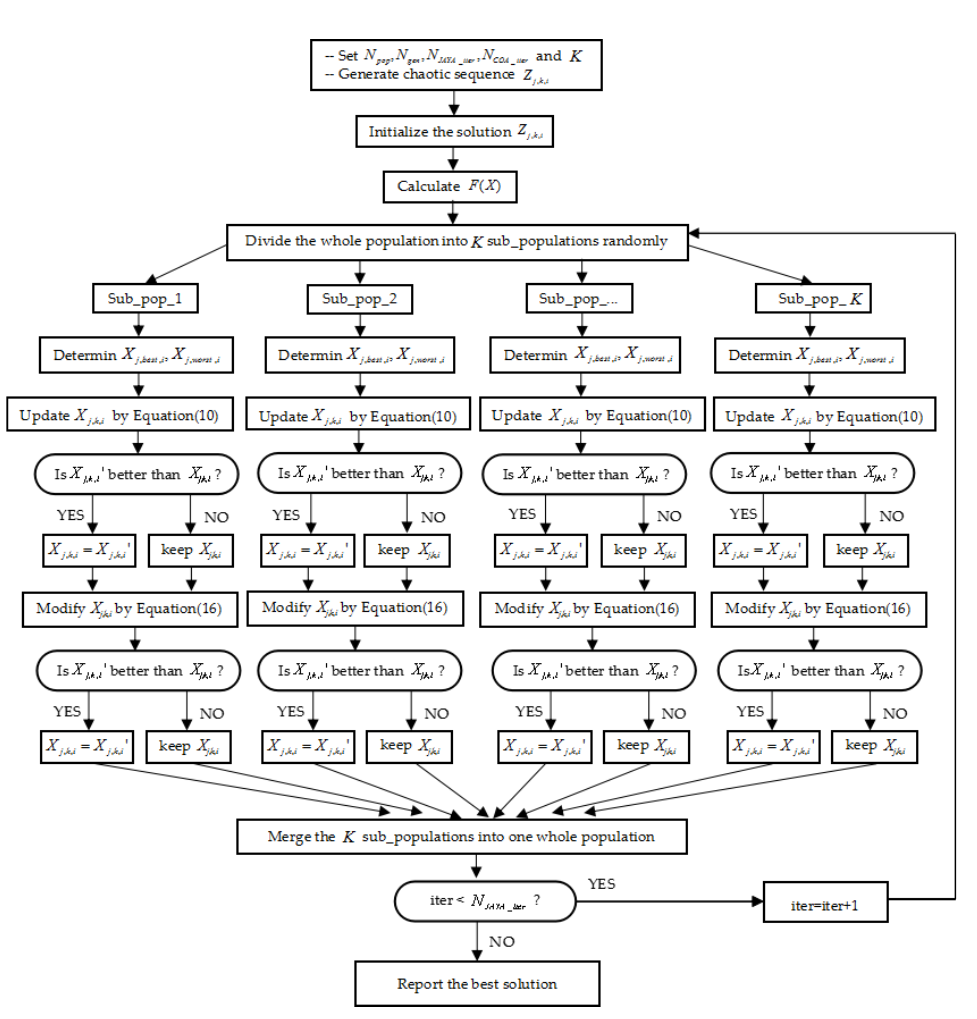
Figure 1. Flow chart of the MP-CJAYA Algorithm. Algorithm 1 Pseudo code of the MP-CJAYA Algorithm